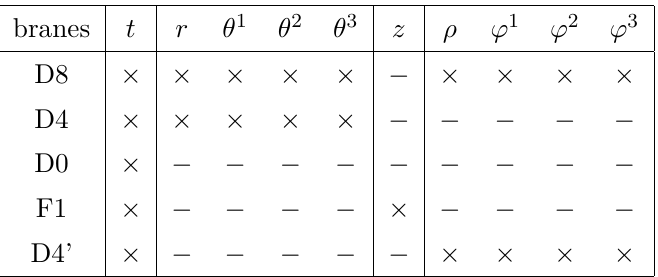
Table 6 . The brane picture of D0-F1-D4’ branes ending on the D4-D8 system [53]. The intersection is